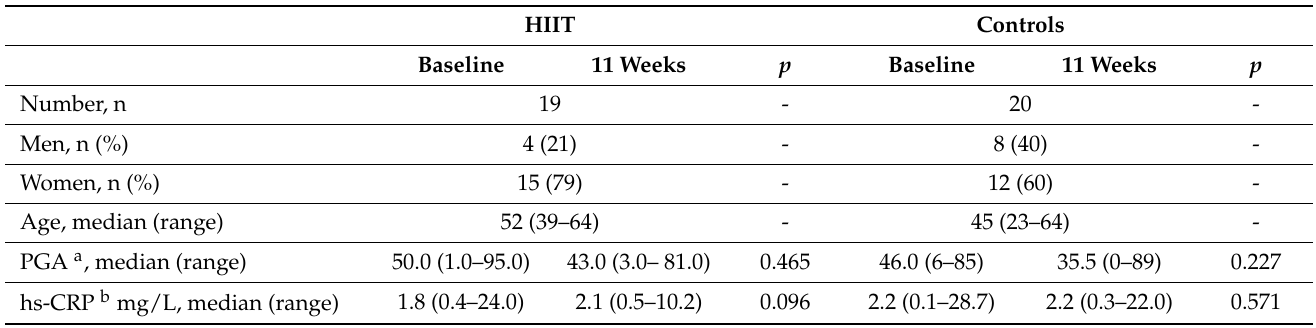
Table 1. Demographic characteristics of study participants in high intensity interval training (HIIT) and control groups, and their scores for joint affection and pain at baseline and after 11 weeks [15]. Mean values of scores for joint affection and pain within groups at baseline and 11 weeks were compared by the Wilcoxon signed-rank